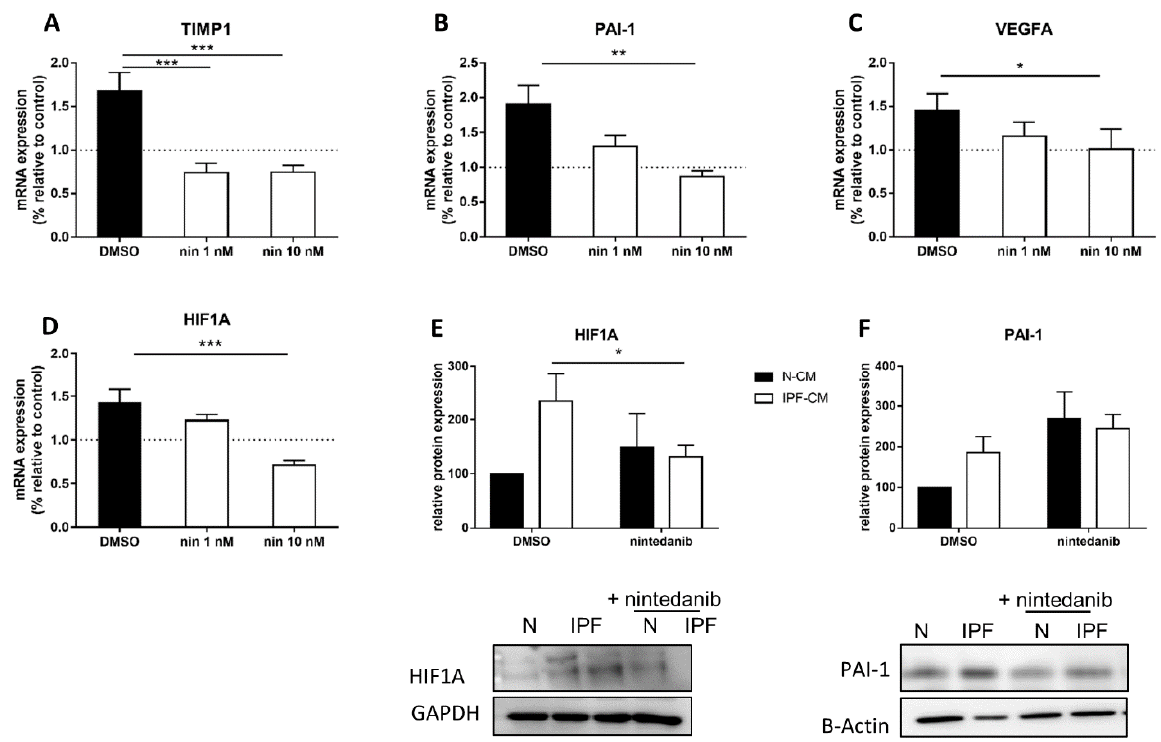
Figure 3. Nintedanib prevents the elevation of HIF1 α -related targets. Normal human lung fibroblasts (N-HLF) were exposed to nintedanib (1–10 nM) or DMSO for 60 min and the cultured on N/IPF-CM for 24 h additional without nintedanib or DMSO. Effects of the IPF-CM with/without nintedanib (nin) on TIMP1 ( n = 6), PAI-1 ( n = 6) and VEGFA ( n = 6) and HIF1A ( n = 6) mRNA levels and on HIF1 α ( n = 6) and PAI-1 ( n = 6) protein levels were tested by qPCR ( A – D ) and Western Blot ( E , F ), respectively following 24 h. Values are means ± SEM. * p < 0.05, ** p < 0.01 and *** p < 0.001.